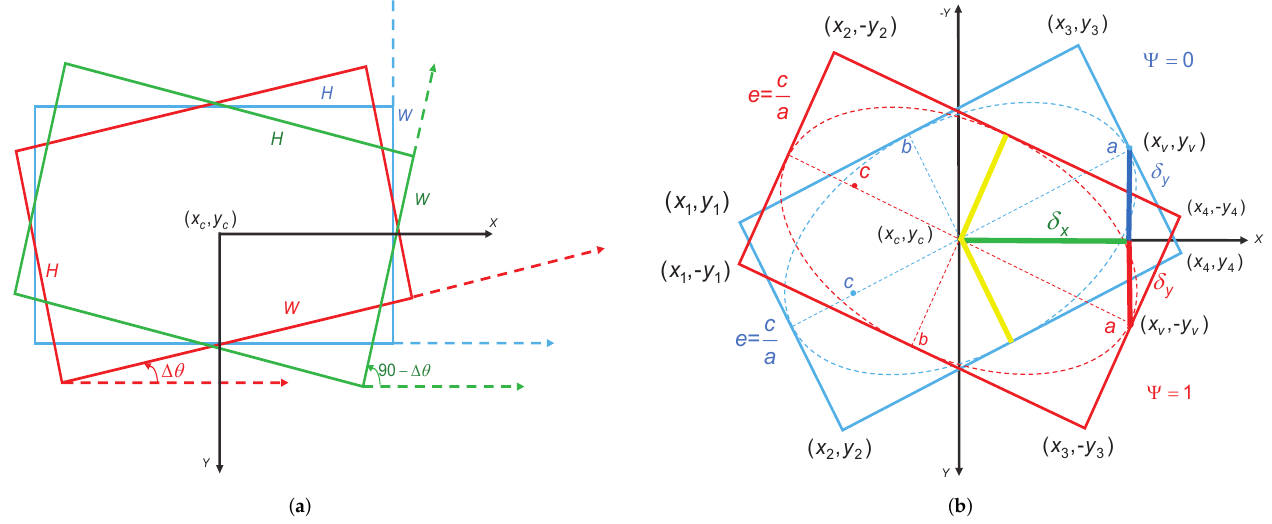
Figure 4. ( a ) RRB representation ( x , y , w , h , θ ) , where ( x c , y c ) , w , h , and (cid:52) θ represent the center point, width, height, and small angle jitter, respectively. ( b ) RIE representation of the target used in our method. ( x c , y c ) , ( x v , y v ) , and { ( x ) | i = 1,2,3,4 } are the center point, long half-axis vertex, and four outer rectangle vertices of the RIE. e and ψ i , y i represent the eccentricity and orientation label, respectively. Yellow lines b denote the short half axis. Red, blue, and green lines ( δ x , δ y ) represent the offsets of the long half axis a